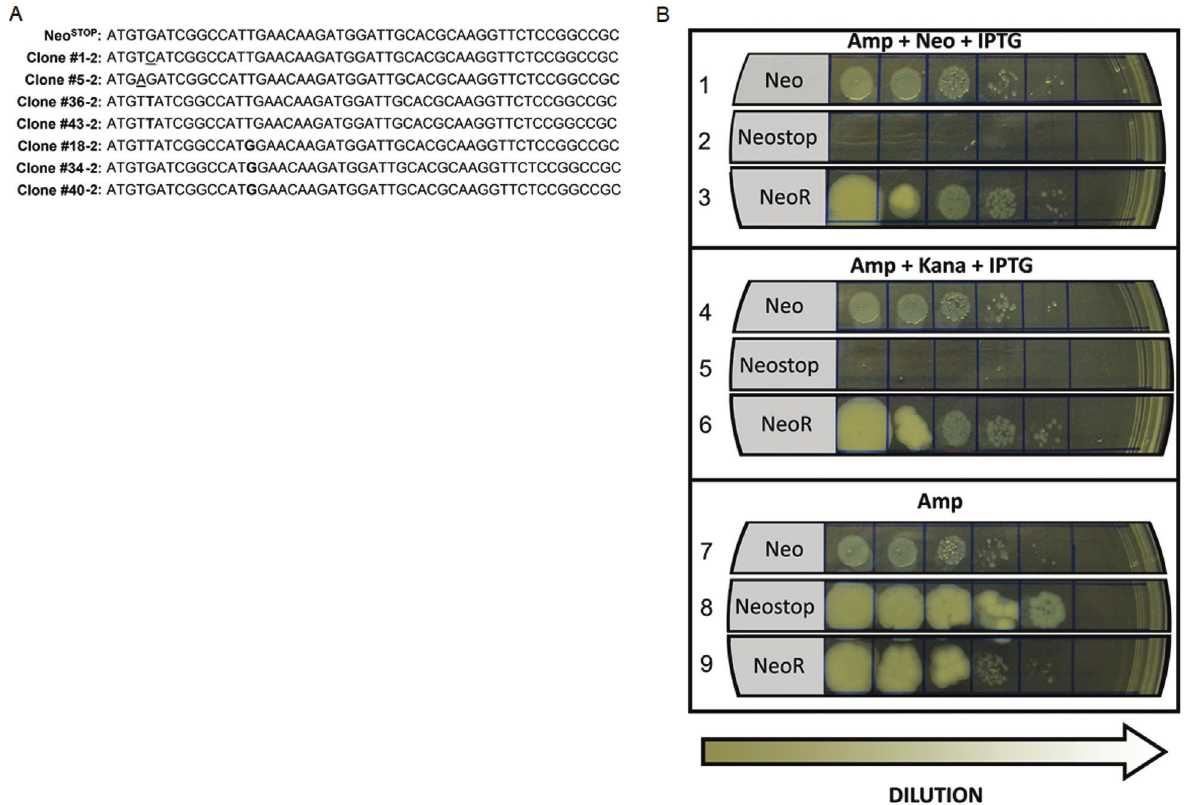
Figure 4 - Neo stopT (cid:3) G transversion can rescue aminoglycoside resistance to DH5 (cid:4) . (A) Sequencing analysis of G418-resistant clones shows that expo- sure to H 2 O 2 leads to classic transversions arisen from oxidative damage (bold-type letters). Oxidative-unrelated mutations were also found (underlined letters). (B) To verify if T (cid:3) G at position 15 could restore aminoglycoside resistance in DH5 (cid:4) we generated this transversion through the use of the primer Neo stopT (cid:3) G_FW (#6, Table 1) – which generates a start codon into the Neo stop – to obtain the Neo stopT (cid:3) G reporter, that confers kanamycin- and neomycin-resistance to DH5 (cid:4)